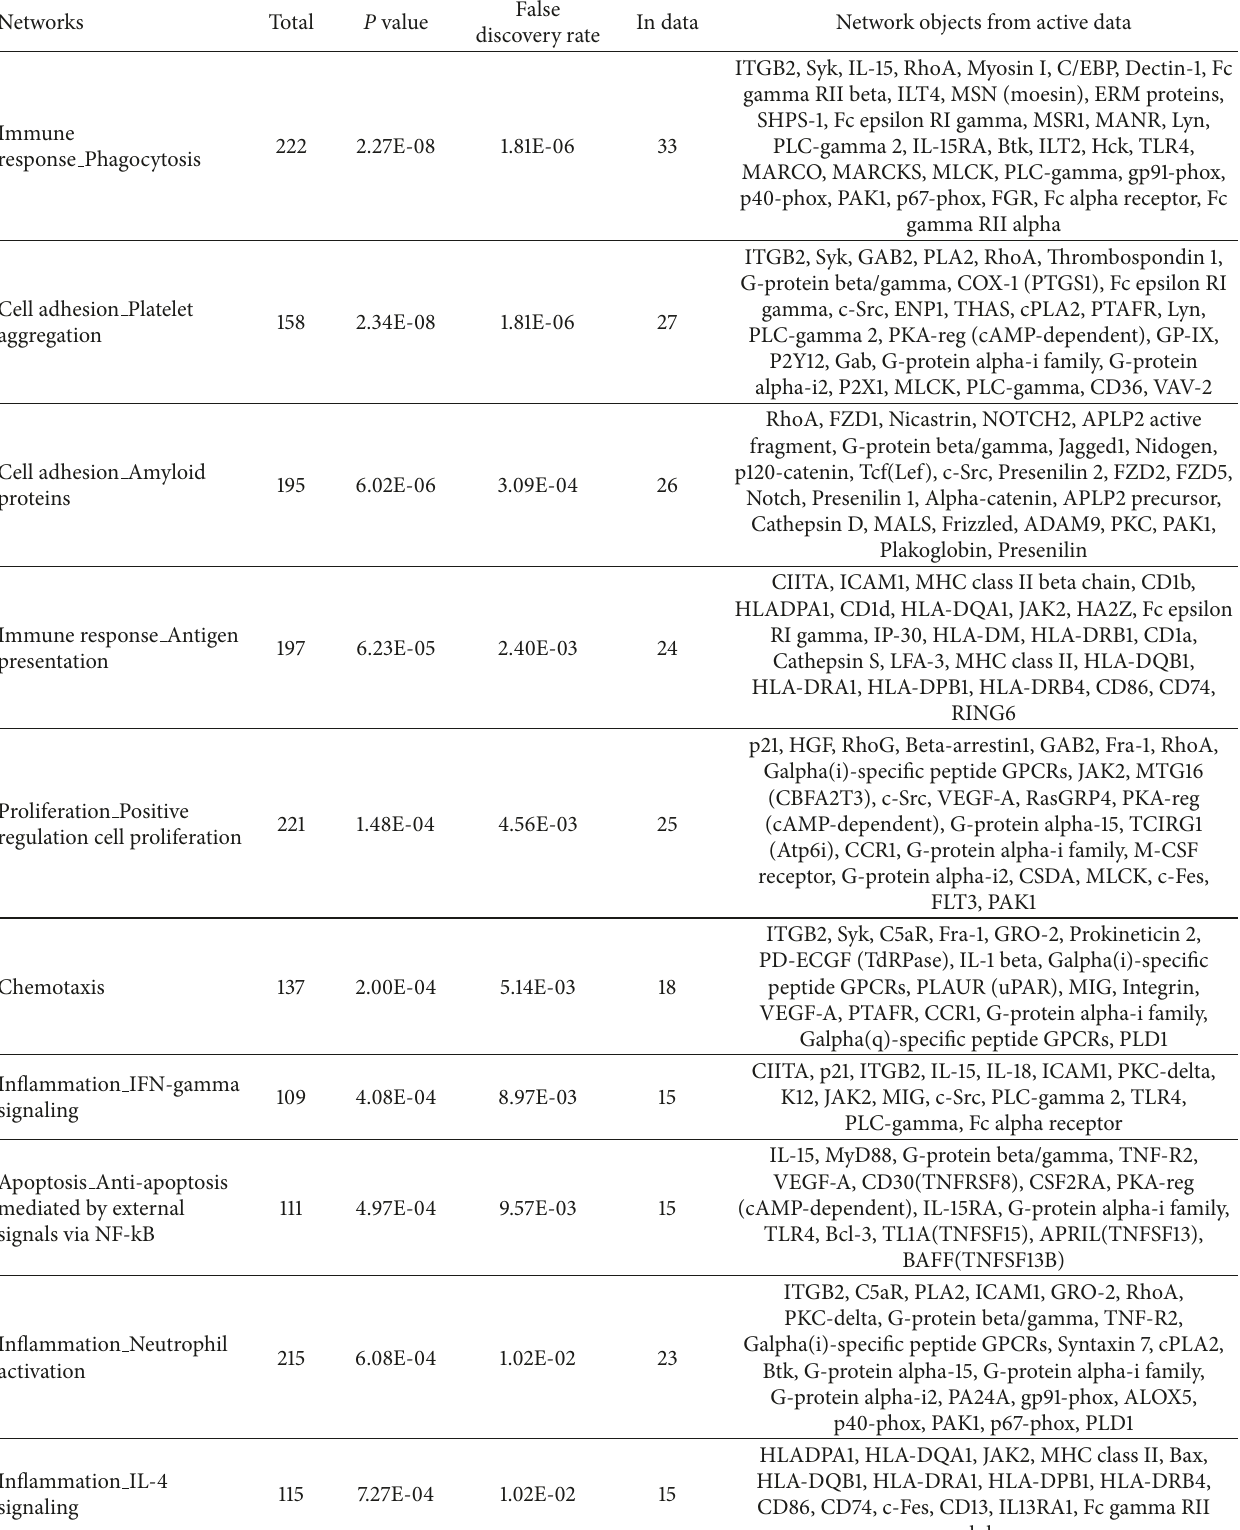
Table 1: Biological process networks for 1063 genes whose expression in peripheral CD4+ cells was positively correlated with serum eotaxin